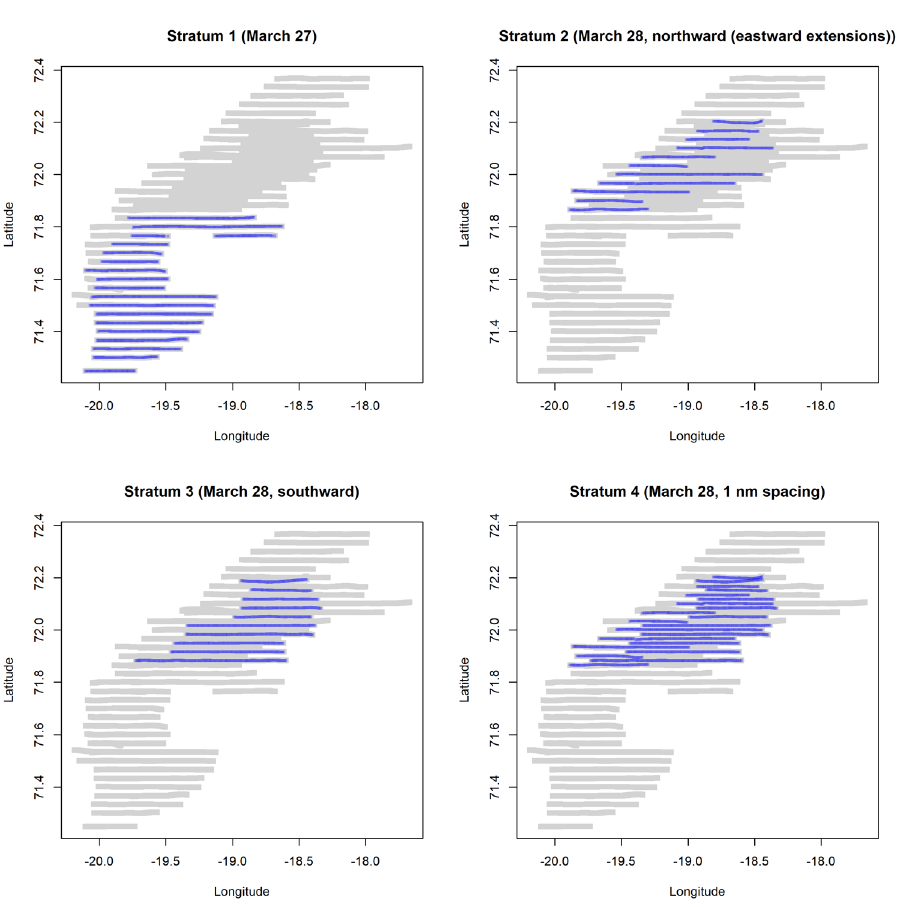
Figure 6. Maps showing the distribution of photographs designated to the four modified strata (blue), overlaid on all surveys combined